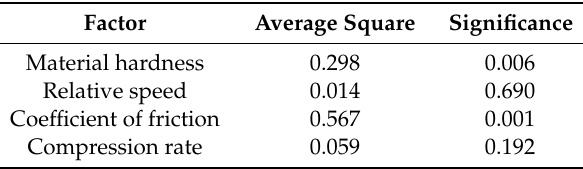
Table 3. ANOVA of stable